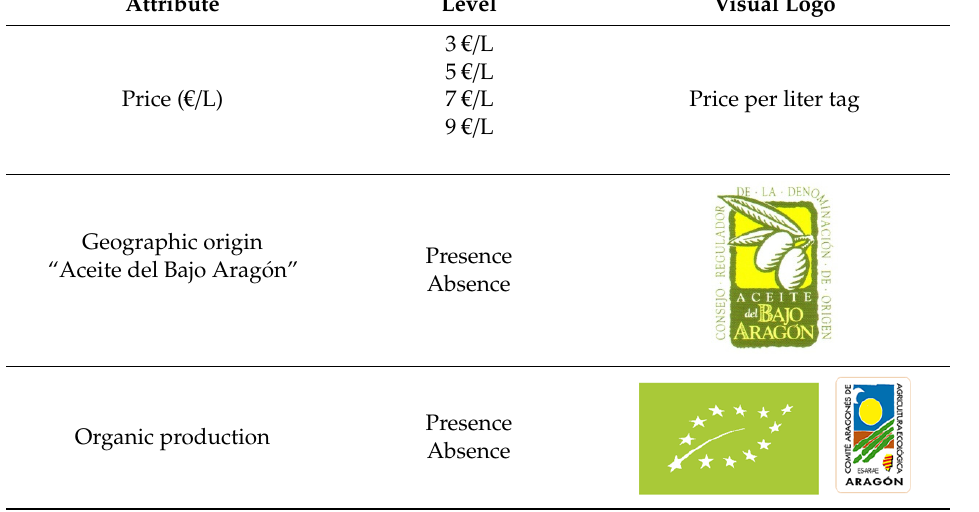
Figure 1. Choice set example of the unlabeled experiment *. * Original figures were presented in Spanish, Source: own elaboration.